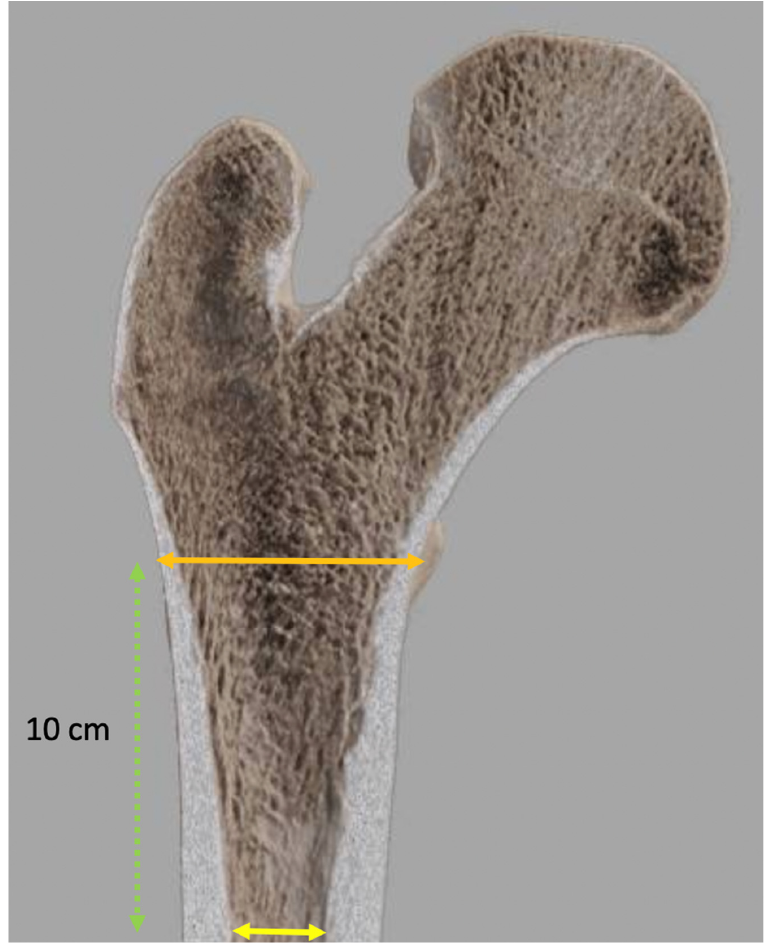
Figure 6. Cortical index calculation. Cortical index is calculated by measuring the ratio between the diaphyseal diameter between the cortices at the level (orange double ‐ headed arrow) and the diaphyseal diameter between the cortices at the level (orange double-headed arrow) and the inner inner canal diaphyseal diameter 10 cm below the lesser trochanter (yellow double ‐ headed arrow). canal diaphyseal diameter 10 cm below the lesser trochanter (yellow double-headed